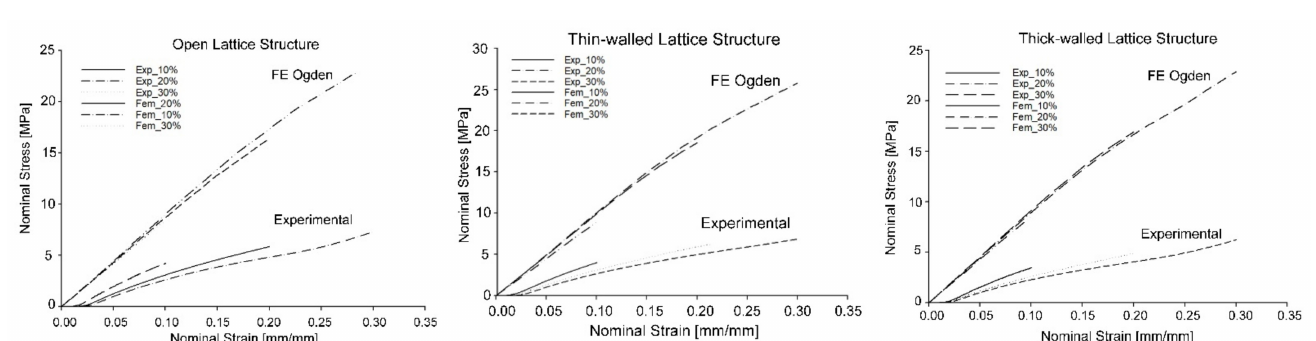
Figure 10. Nominal stress-strain curves of lattice structures, experimental and